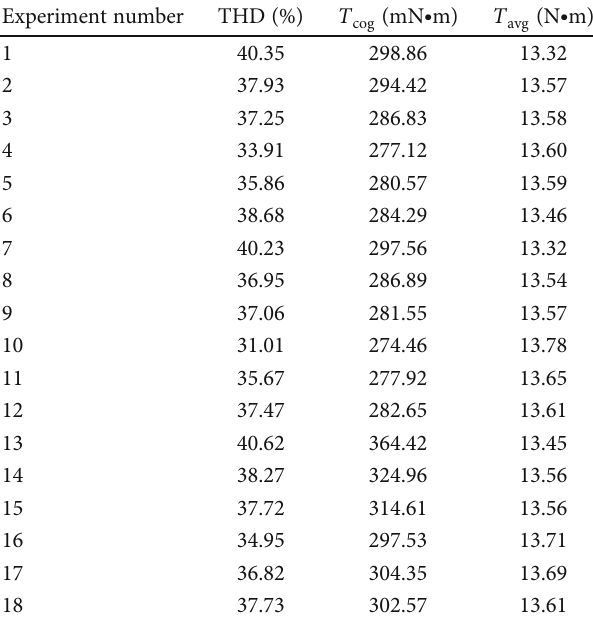
Table 4: Orthogonal experimental results.